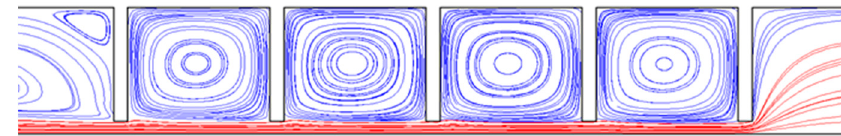
Figure 2. Steady-state streamline of a supercritical CO 2 see-through labyrinth seal.